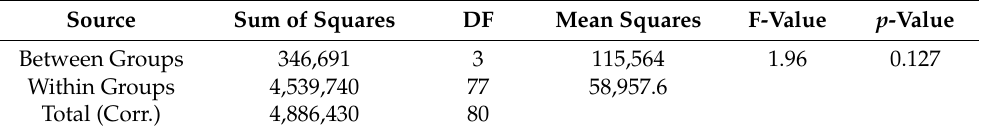
Table 2. ANOVA between the means of solar radiation on 23, 26, 27, and 28 August. Source Sum of Squares DF Mean Squares F-Value p -Value Between Groups 346,691 3 115,564 1.96 0.127 Within Groups 4,539,740 77 58,957.6